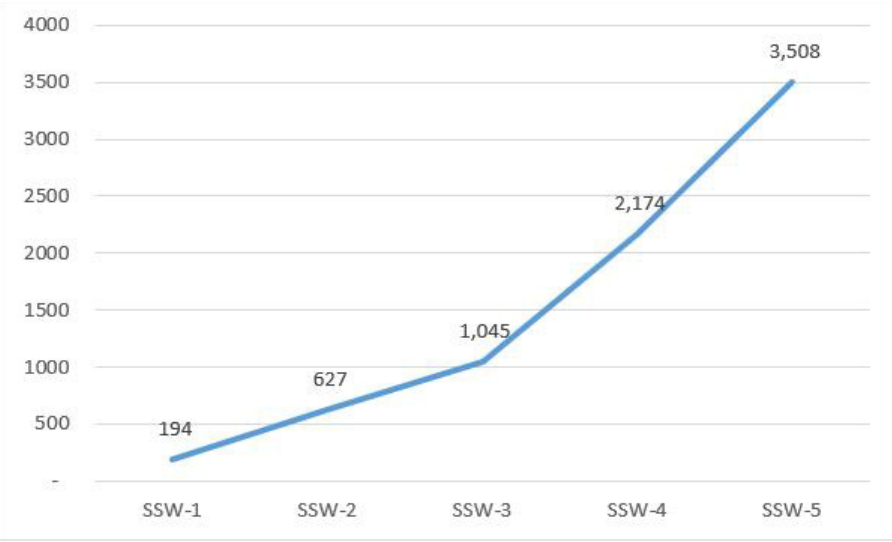
Figure 6. Number of roads affected by flooding at each SSW level.